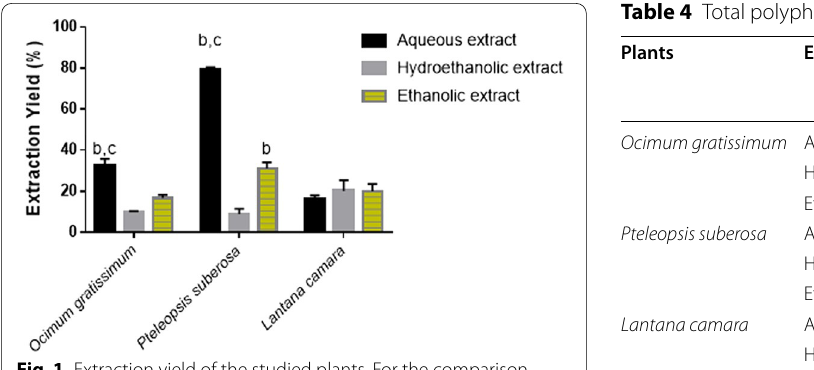
Fig. 1 Extraction yield of the studied plants. For the comparison between the extracts of each plant: a: significant different from aqueous extract, b: significant different from hydroethanolic extract and c: significant different from ethanolic Table 3 Results of the qualitative screening of the powder of studied plants